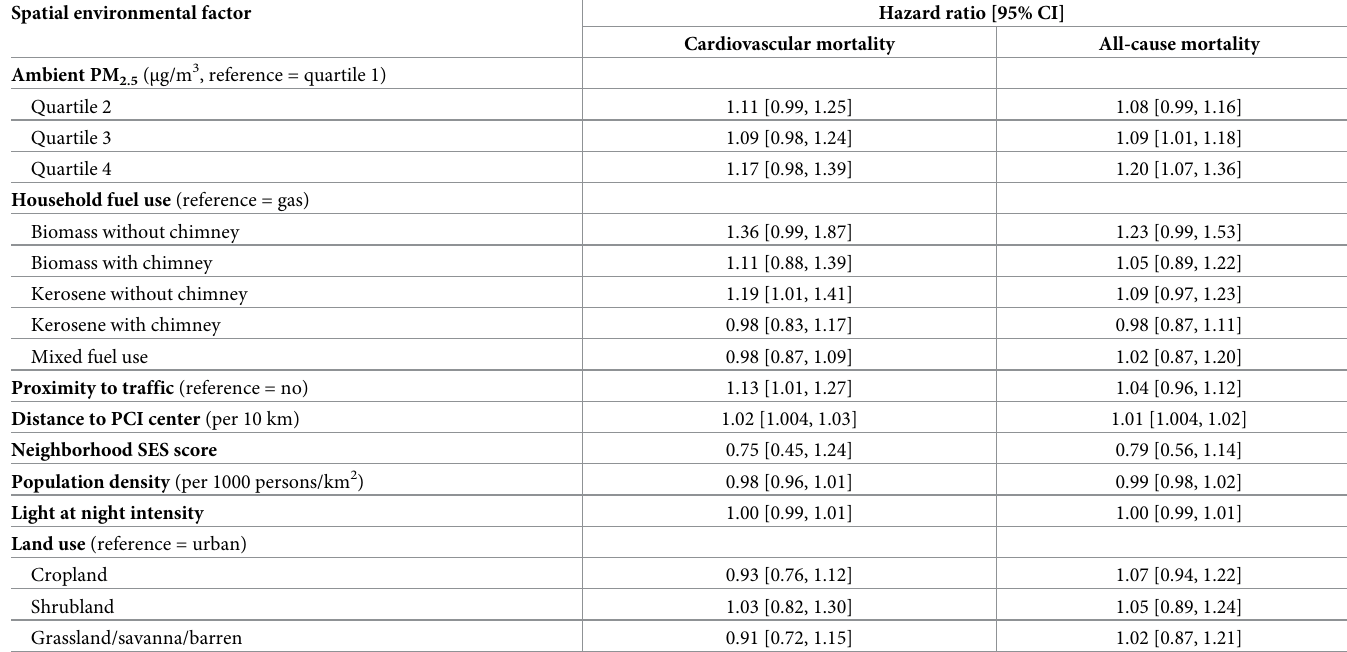
Table 4. Hazard ratios for eight spatial environmental factors.